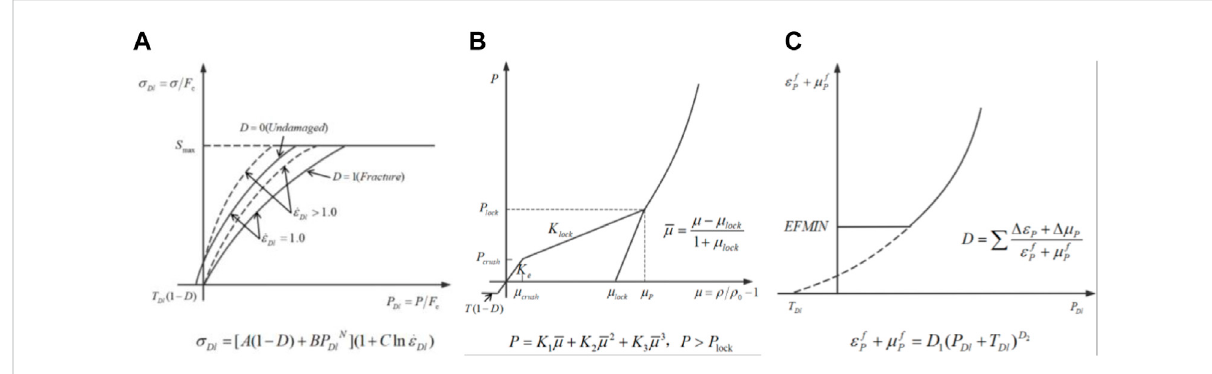
FIGURE 4 HJC constitutive model. (A) Yield surface equation, (B) State equation, (C) Damage